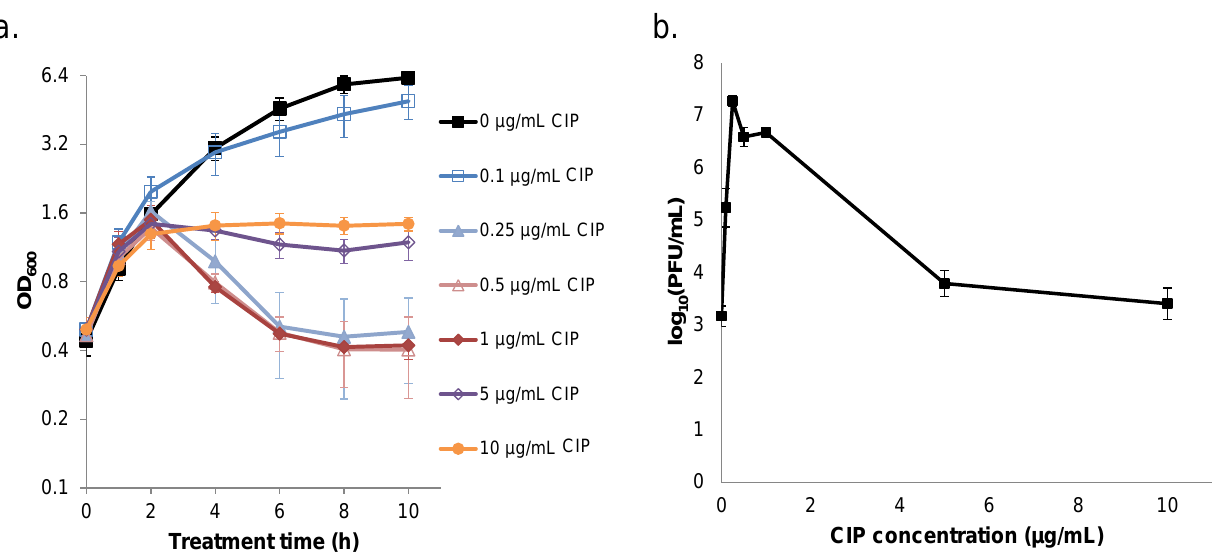
Figure 2. Measurement of cell lysis and bacteriophage release in cultures treated with ciprofloxacin (CIP). S. aureus NCTC 8325 was grown in LB for 4 h prior to treatment with 0–10 µg/mL CIP. ( a ) At designated time points, samples were collected for OD 600 measurements. Data points represent the mean and error bars the SEM of three replicates, except for the untreated control that was replicated twice. ( b ) After 10 h of CIP treatment, samples were filter sterilized and the effluent was assayed for plaque forming units (PFUs). Data points are the mean of the log 10 (PFU/mL) across three replicates, and error bars represent SEM. We note that, for 50 µg/mL CIP, antibiotic present in the effluent interfered with PFU measurements, and this was not observed for treatments of ≤ 10 µg/mL (Figure S1a). Therefore, for consistency between the panels presented here, OD 600 measurements of 50 µg/mL can be found in Figure